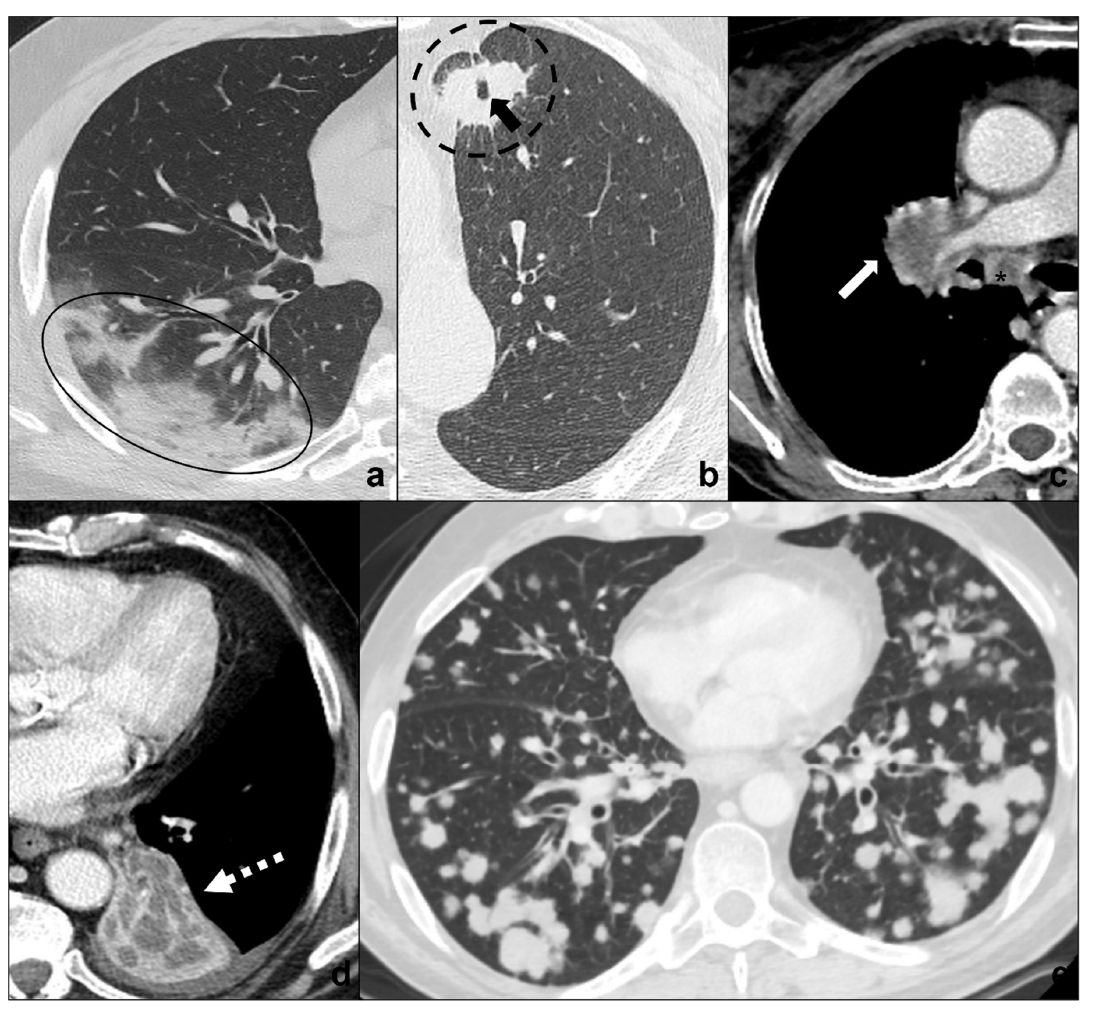
Figure 5. ( a – e ) Chest CTs showing differential diagnoses of COVID-19 pneumonia stage 3/consolidations. Subpleural ill-defined consolidations are typical of COVID-19 pneumonia stage 3 (black circle) and are generally easy distinguishable from lung cancer, especially if lung tumors present as big masses with spiculated margins, pleural retraction striae (dotted black circle in ( b )), cavitations (black arrow in ( b )) and lymphadenopathies (black asterisk in ( c )). Contrast administration is useful to appreciate the inhomogeneous enhancement of lung tumor and mediastinal tissue infiltration (white arrow in ( c )), and/or additional findings such as lobar atelectasis (dotted white arrow in ( d )) secondary to bronchial invasion with progressive lobar hypoventilation and secretive stagnation. Solid metastases ( e ) may be differentiated by COVID-19 consolidations because they appear as roundish nodules with regular margins and a random distribution in relation to hematogenous spread. Lungs: mean window with 1500 HU; mean window level − 600. Mediastinum: mean window with 350 HU; mean window level 50